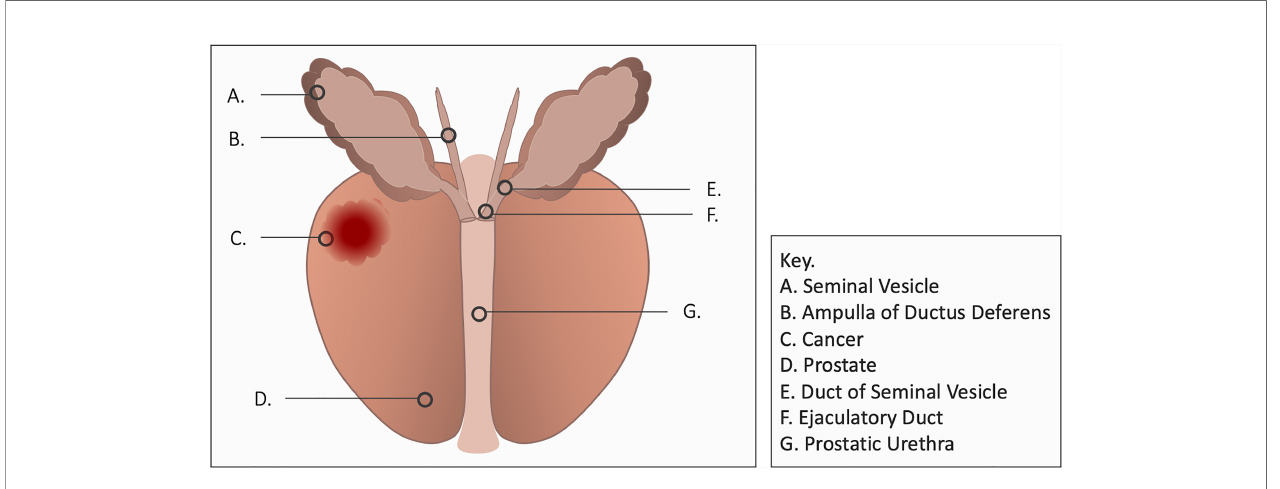
FIGURE 1 | Ejaculatory Ducts of the Prostate.